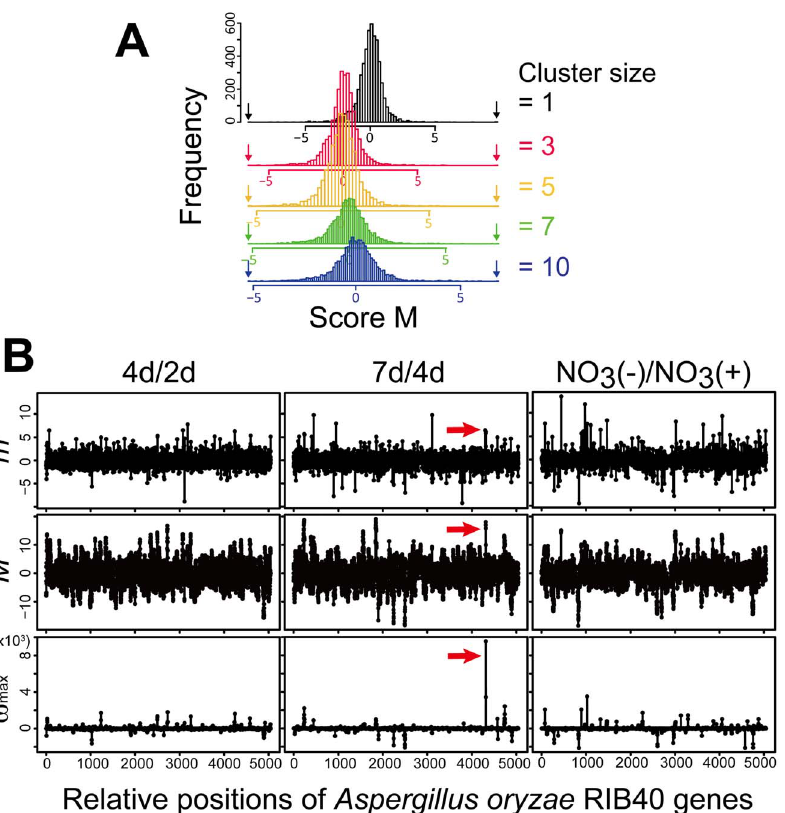
Figure 2. Behavior and performance of MIDDAS-M in A.oryzae . (A) Histograms of M scores at ncl =1, 3, 5, 7, and 10 in the transcriptomes at 7 vs. 4 days of cultivation in kojic acid (KA)-production medium. The symmetry broke at a cluster size of 3 because of the emergence of large M scores due to the induction of the KA cluster genes. Arrows at the termini of the x -axis indicate the smallest and the largest values. (B) Emergence of a v max peak by MIDDAS-M from the raw induction ratio. The x -axis designates relative position of the genes on the A. oryzae RIB40 genome when eight chromosomes are concatenated into one. The y -axis scales are the same for all three datasets in the same raw. The v max peak indicated by the red arrow corresponds exactly to the three genes responsible for KA production.